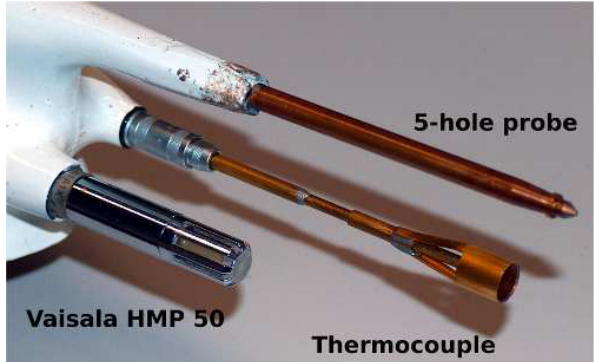
Fig. 2. The meteorological sensors of the M 2